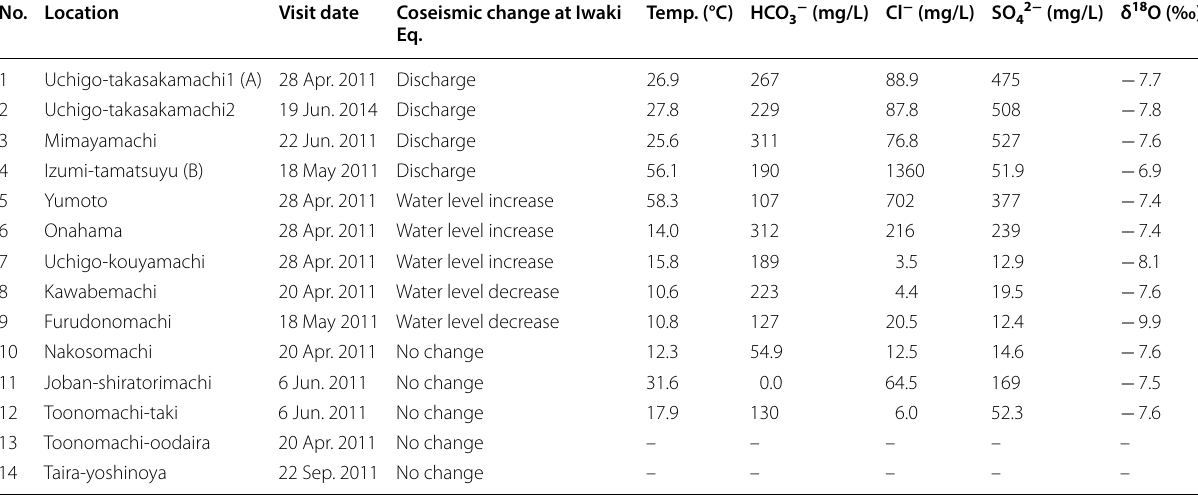
“No.” corresponds to the number in Fig. 2